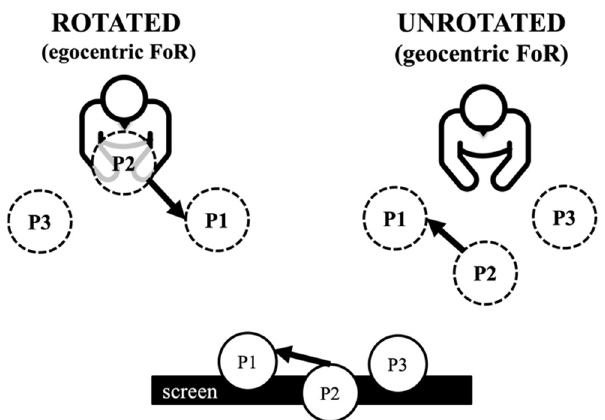
Figure 9. A new reading of Senghas (2003, p. 518)’s proposal in terms of spatial Frames of Reference. The diagrams represent the signers and the signing area as viewed from above. The circles with P1, P2 and P3 indicate where the signers created R-Loci (RL) and the arrows represent the movement of the sign performed in the signing space. This representation is based on the action presented in a video clip on the screen (represented by a black line in the bottom of the image).